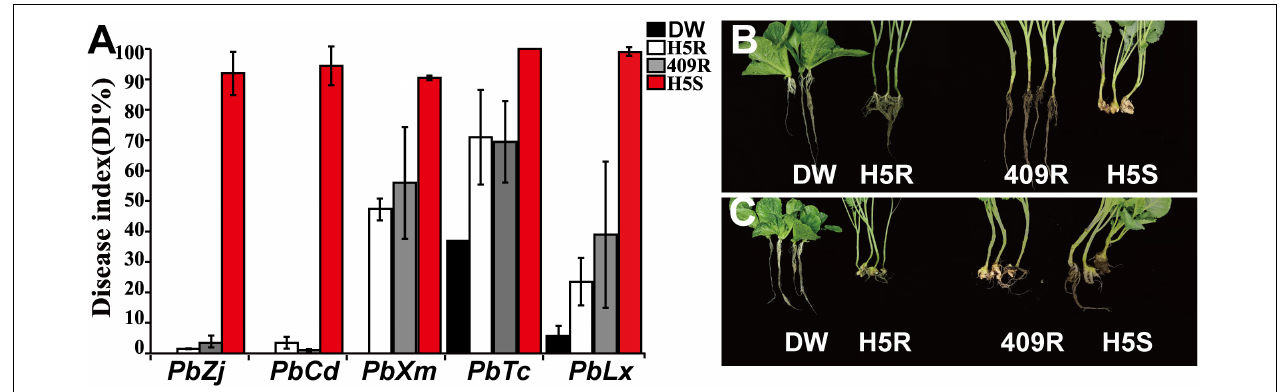
FIGURE 1 | Disease resistance responses of different materials to P. brassicae from different field isolates. (A) Disease index statistics. Black, white, gray, and red bars represent the disease index in DW, Huashuang5R (H5R), 409R, and Huashuang5S (H5S), respectively. (B,C) The phenotypes of DW, H5R, 409R, and H5S were inoculated with PbZj and PbXm ,